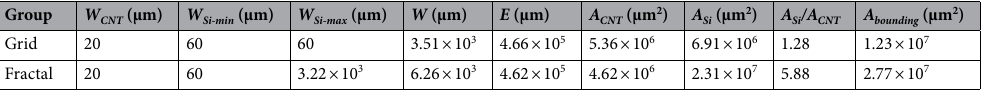
Table 1. Geometric parameters for the grid and fractal